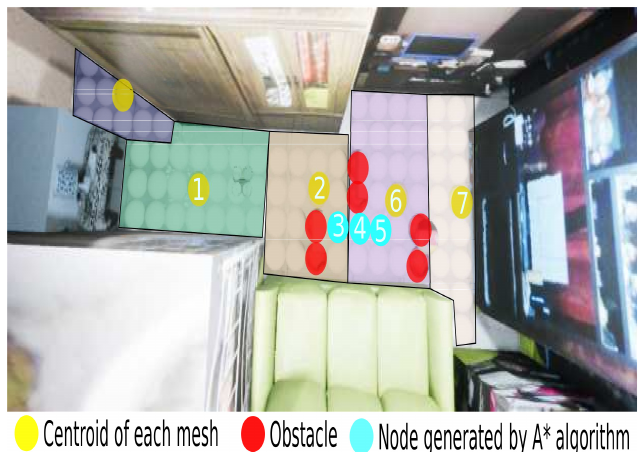
Figure 8. Visual representation of the best path using navigation meshes.